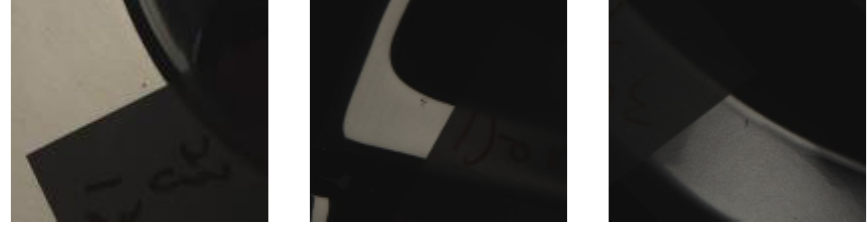
Figure 16. Photographs examples of the three types of defect addressed in this study.